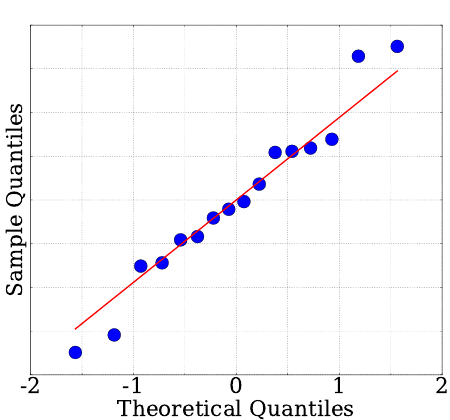
Figure 16: Distribution of residuals after modeling for mass pressure